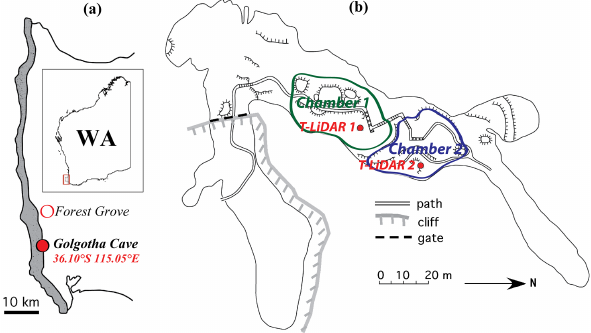
Figure 1. (a) SWWA map showing the coastal belt of dune cal- carenite (inset figure indicates the SWWA region). (b) Plan view of the Golgotha Cave map showing both chambers (green and blue marked areas) and T-LiDAR positions (red dots) (adapted from Mahmud et al., 2015). Chamber 1 contains sampling area 1 (T- LiDAR 1) and chamber 2 contains sampling area 2 (T-LiDAR 2) of the drip water chemistry monitoring programme operating since 2005 (Treble et al., 2015,